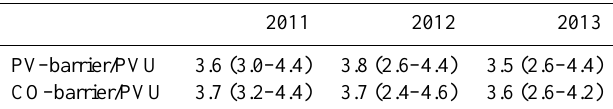
Table 1. Transport barrier PV values for the Asian monsoon anti- cyclone at 380K calculated from maximum PV and CO gradients and maximum-minimum ranges for the years 2011–2013 (averages over all dates between 20 June and 20 August of each year where the transport barrier criterion